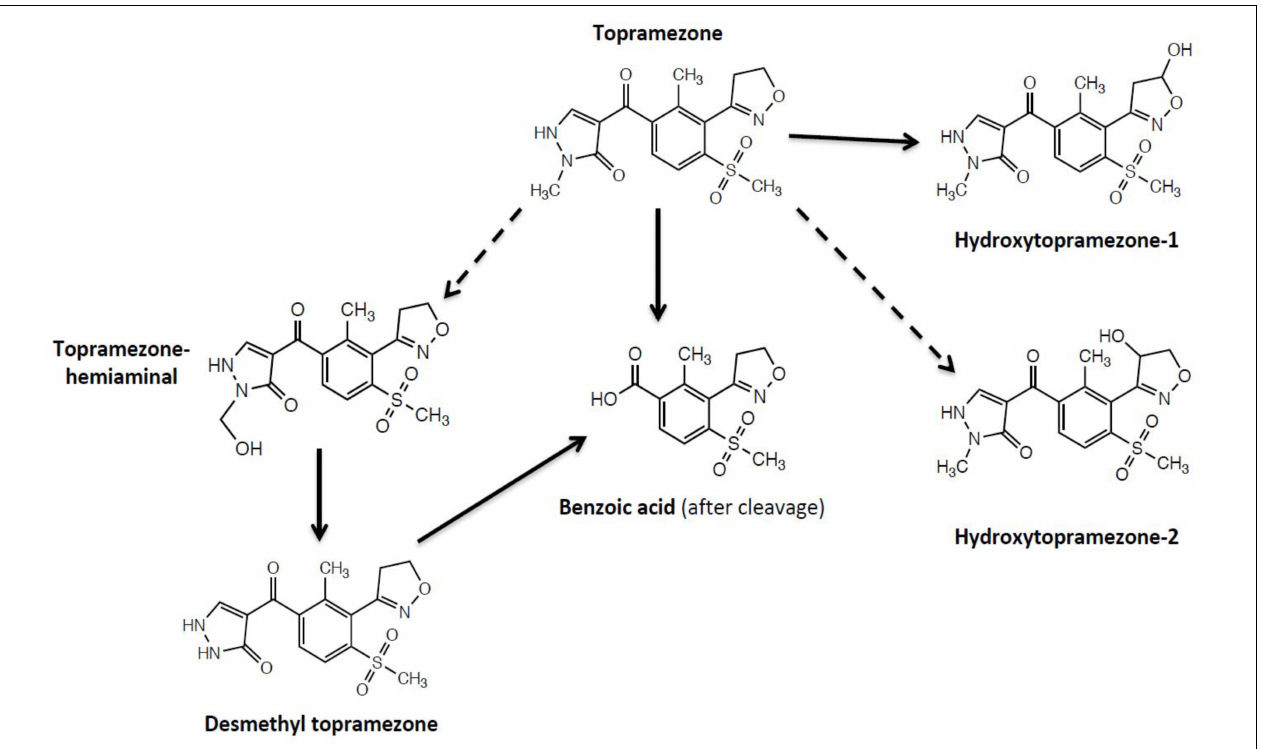
FIGURE 8 | Proposed initial routes of topramezone metabolism in multiple herbicide-resistant waterhemp (SIR population) and tolerant maize. The benzoic acid metabolite of topramezone was only detected in maize, desmethyl-topramezone was a major metabolite formed in maize but minor in SIR, and both hydroxytopramezone metabolites were major metabolites detected in SIR but very low in maize. Dotted lines indicate two possible structures of the hydroxytopramezone-2 metabolite from Figure 7A : the hemiaminal metabolite that likely forms transiently in maize (Kreuz et al., 1996; Grossmann and Ehrhardt, 2007) but possibly accumulates in the SIR population, and a putative isoxazole ring hydroxylation metabolite (positional isomer) that has not been previously reported in plants or animals (United States Environmental Protection Agency,